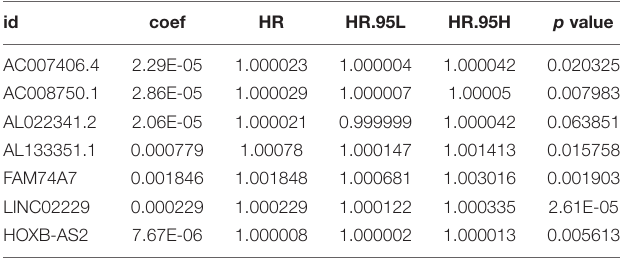
TABLE 2 | Regression coefficients of the seven immune-related